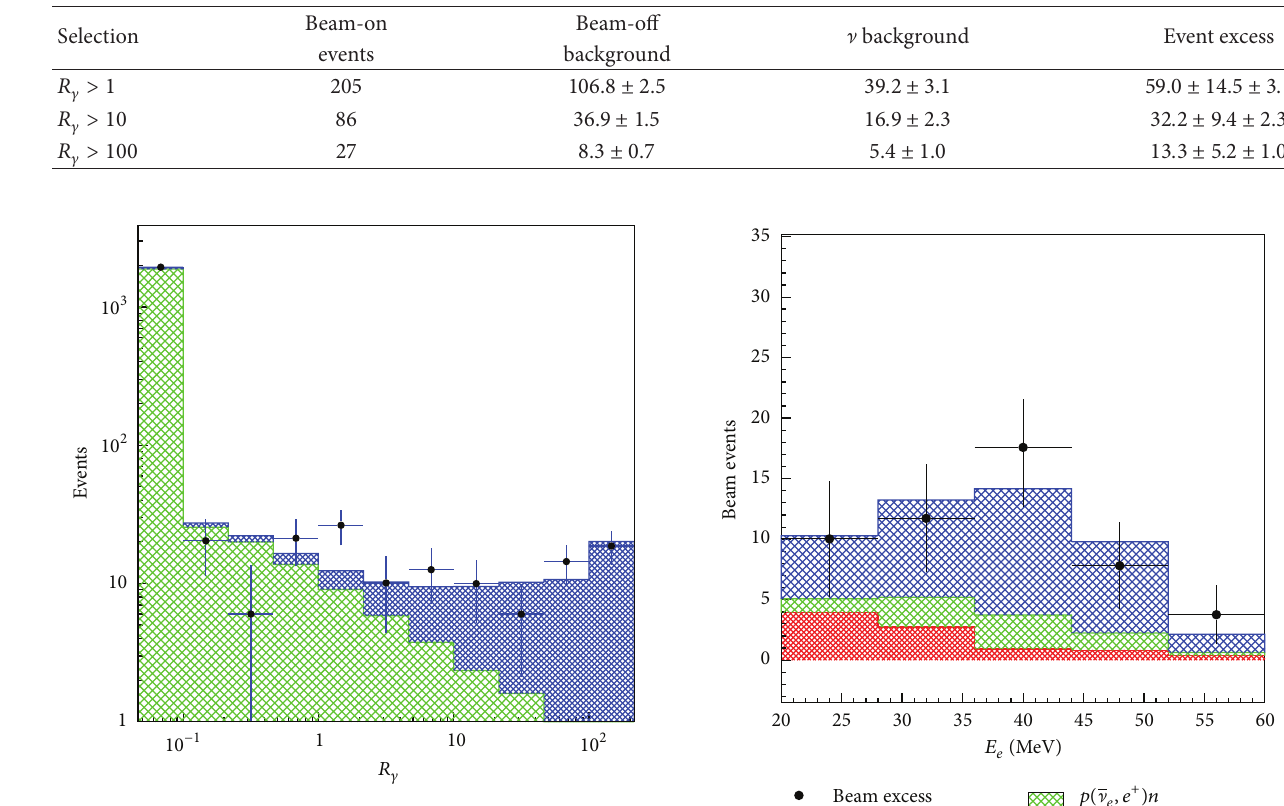
Table 3: Numbers of LSND beam-on events that satisfy the selection criteria for the primary ] 𝜇 → ] 𝑒 oscillation search with 𝑅 𝛾 > 1 , 𝑅 𝛾 > 10 , and 𝑅 𝛾 > 100 . Also the beam-off background, the estimated neutrino background, and the excess of events that is consistent with neutrino oscillations are shown.